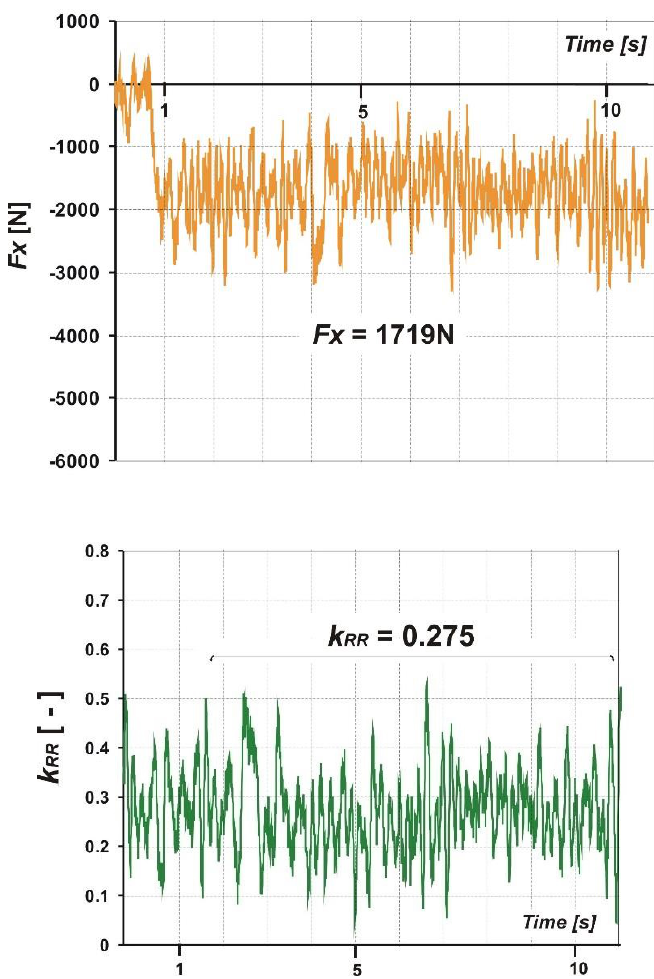
Figure 11. Sample courses of the measured horizontal force, F X , and calculated rolling resistance coe ffi cient, k RR .